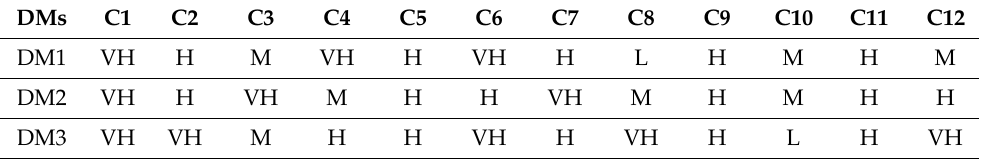
Table 5. Decision makers’ assessment of 12 standard linguistic variables.